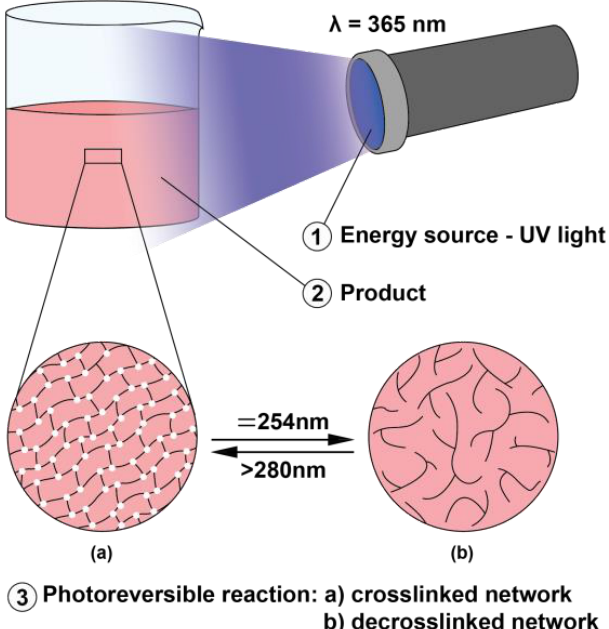
Figure 1. Schematic illustration of the photoreversible process of crosslinking and decrosslinking of a network.